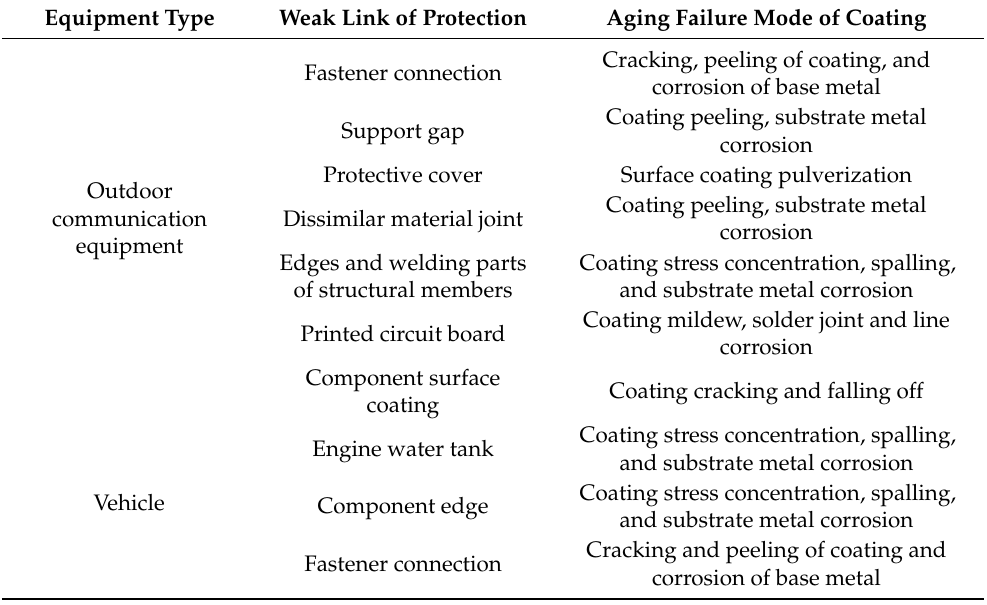
Table 1. Aging failure modes of equipment coatings serviced in marine environments.